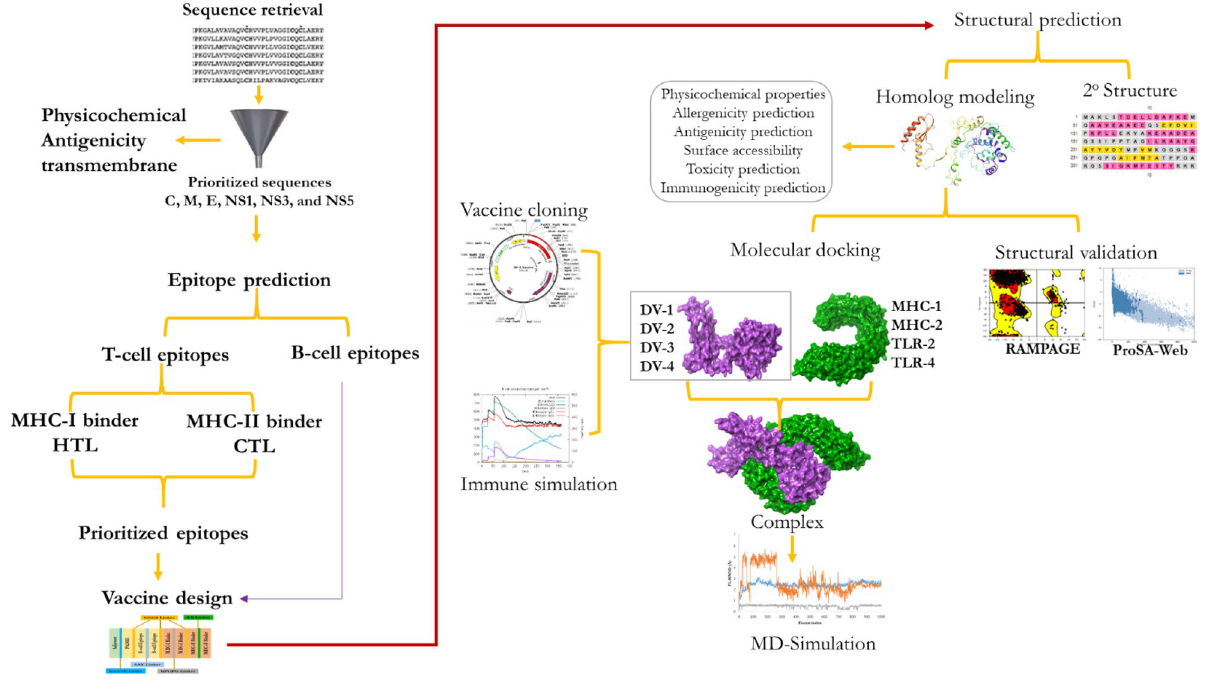
Figure 12. Overview of the study